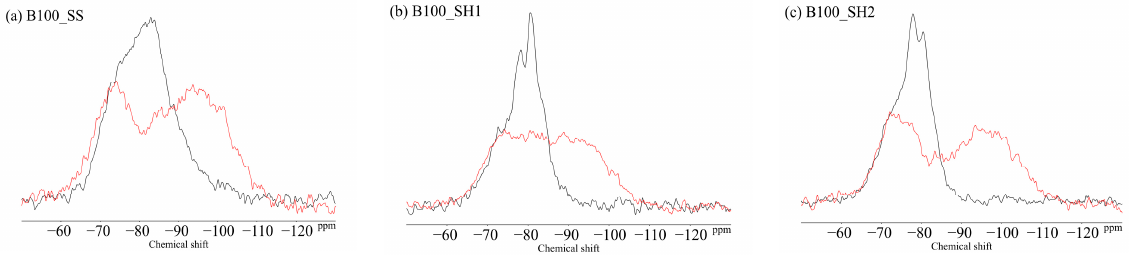
Figure 11. Solid-state 29 Si MAS NMR chemical shifts for ( a ) BFS and ( b ) FA-binders.